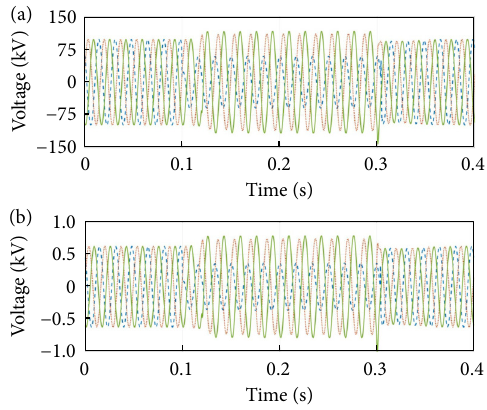
Fig. 4 Results for single-phase-to-ground faults with learning-based AFM. Voltages at ( a ) fault locations and ( b ) microgrids